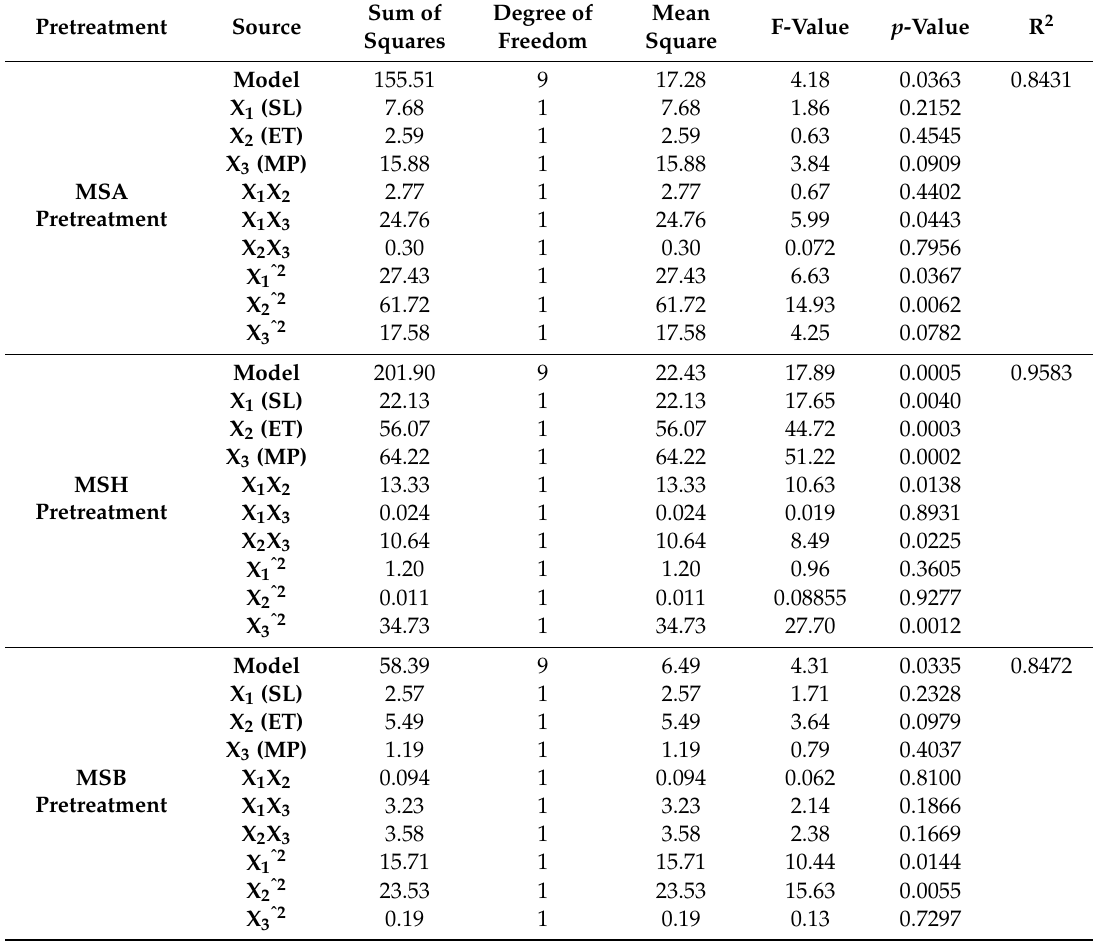
Table 5. ANOVA for xylose models of MSA, MSH, and MSB